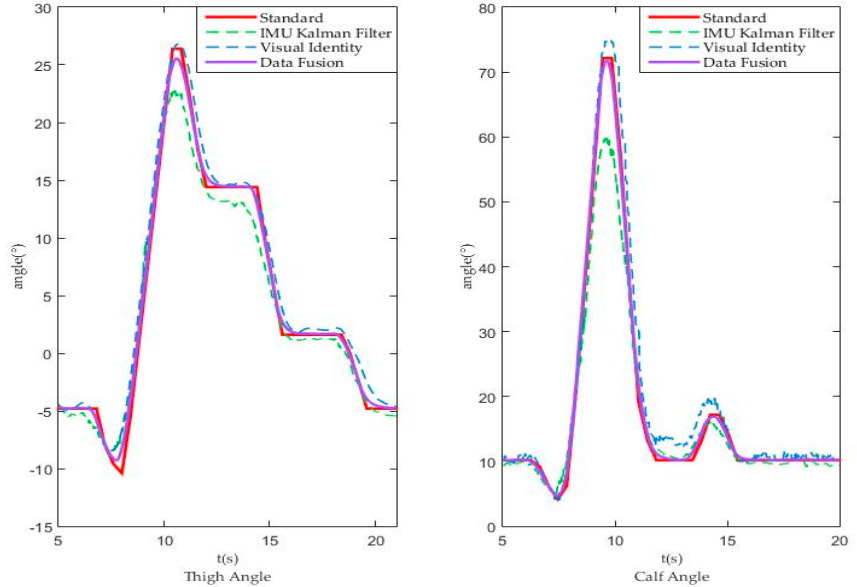
Figure 12. Exoskeleton test without load from different sources.